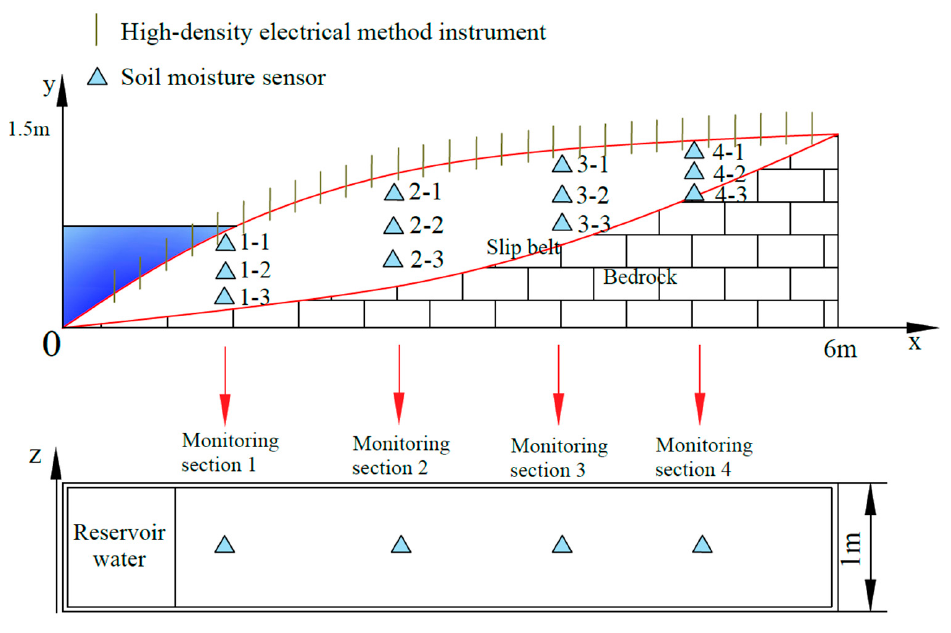
Figure 7. Layout of the model’s physical monitoring points.